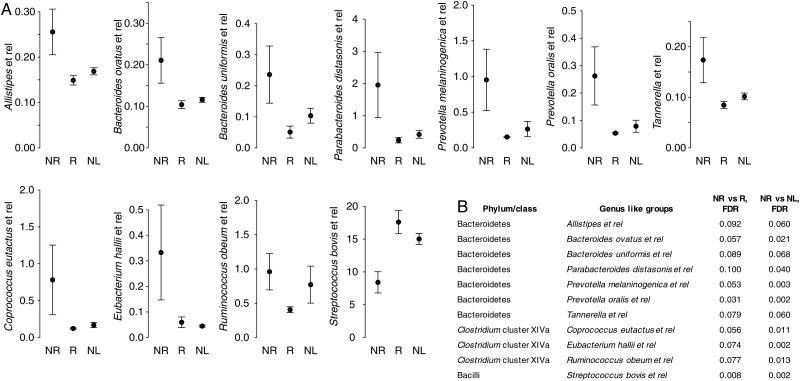
A, Comparison of the relative abundance (median
signal intensity) of all bacterial genuslike groups with a
statistically significant (false discovery rate [FDR], < 0.1)
difference in abundance between both (1) Ghanaian
rotavirus vaccine (RVV) responders (R) and nonresponders (NR) and
(2) Dutch infants (NL) and Ghanaian RVV nonresponders (NR). Plots
show means with standard errors. B, FDRs for the
significantly different genera.